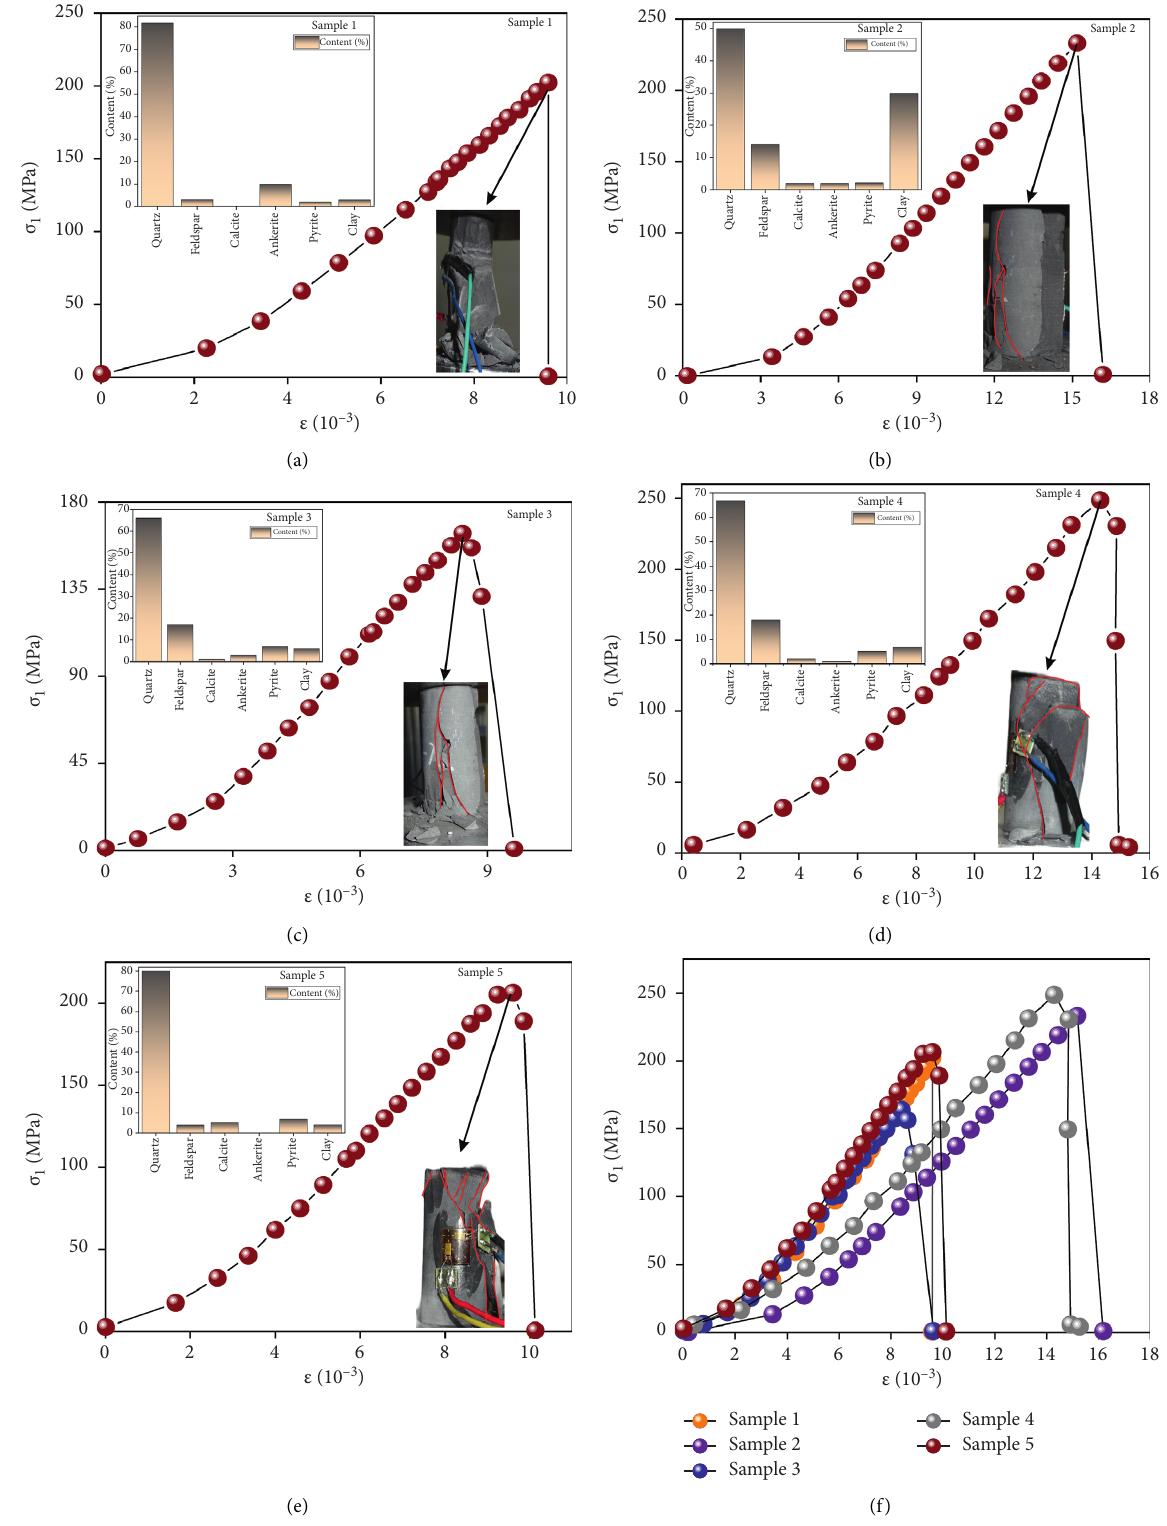
Figure 12: Stress-strain curves and damage characteristics of shales with different mineral